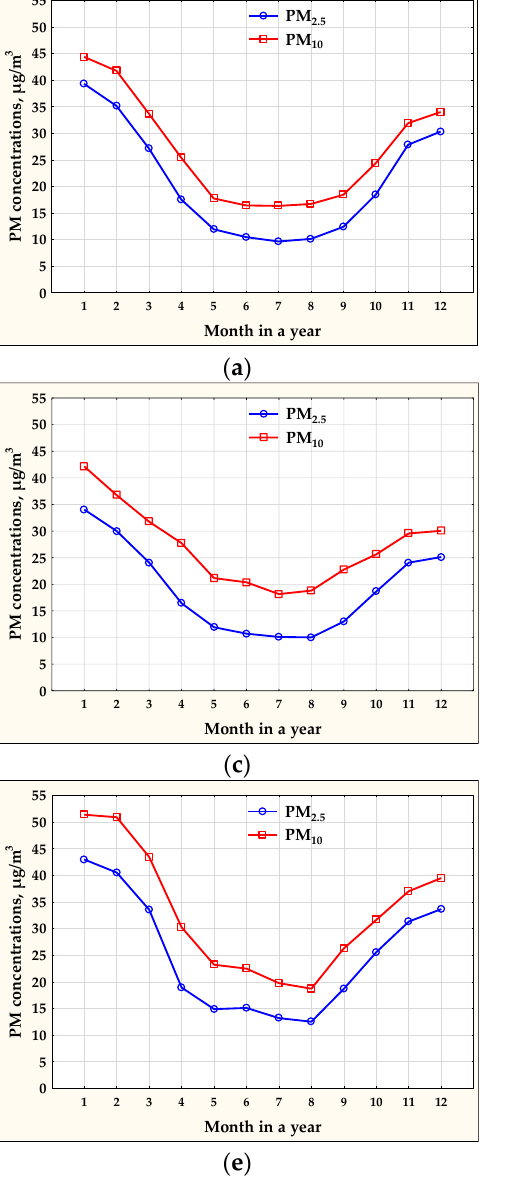
Figure 4. Annual courses of PM 2.5 and PM 10 concentrations at the monitoring stations in: ( a ) Jelenia Gora; ( b ) Lublin; ( c ) Plock; ( d ) Radom; ( e ) Kedzierzyn-Kozle; ( f ) Olsztyn.